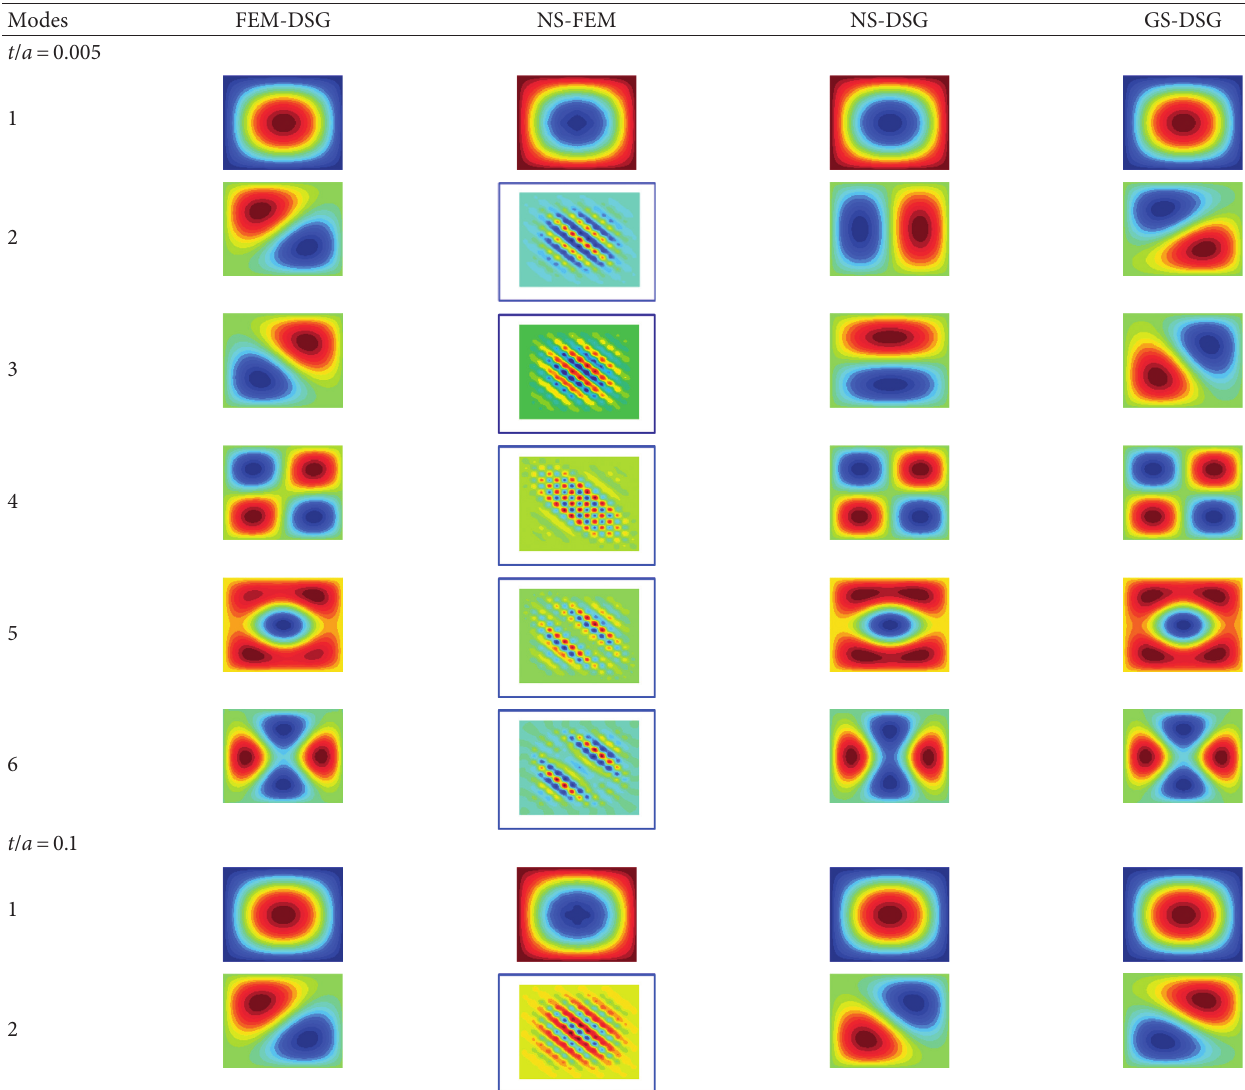
Table 3: First 6 modes of the square plate (SSSS) solved by different methods with 16 × 16